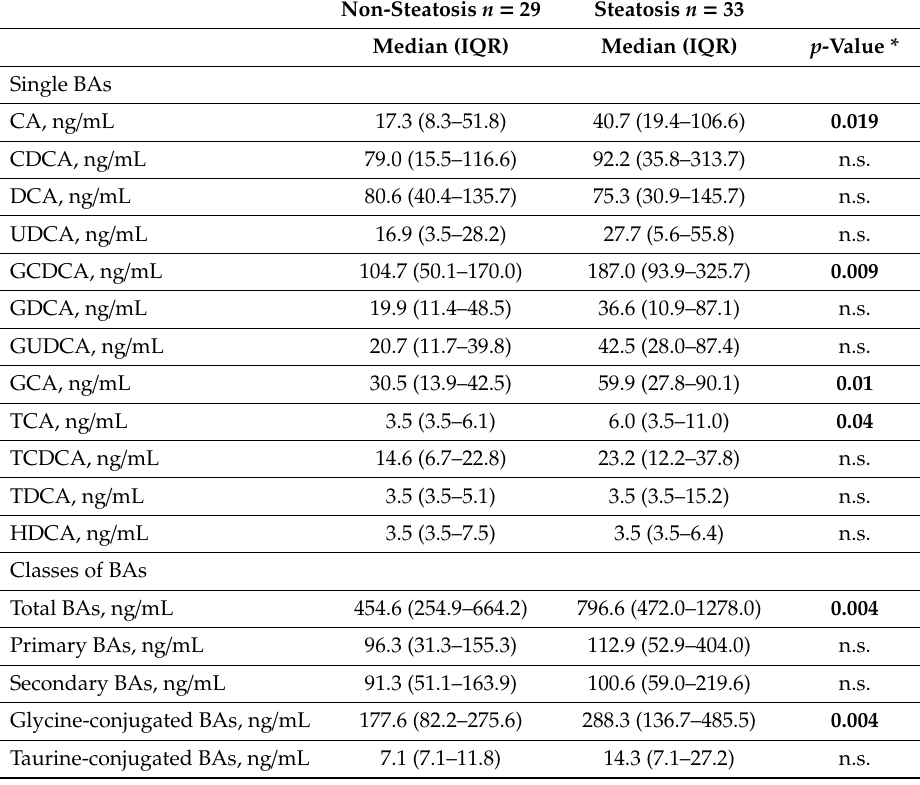
Table 3. Bile acids concentrations in participants with and w / o steatosis.